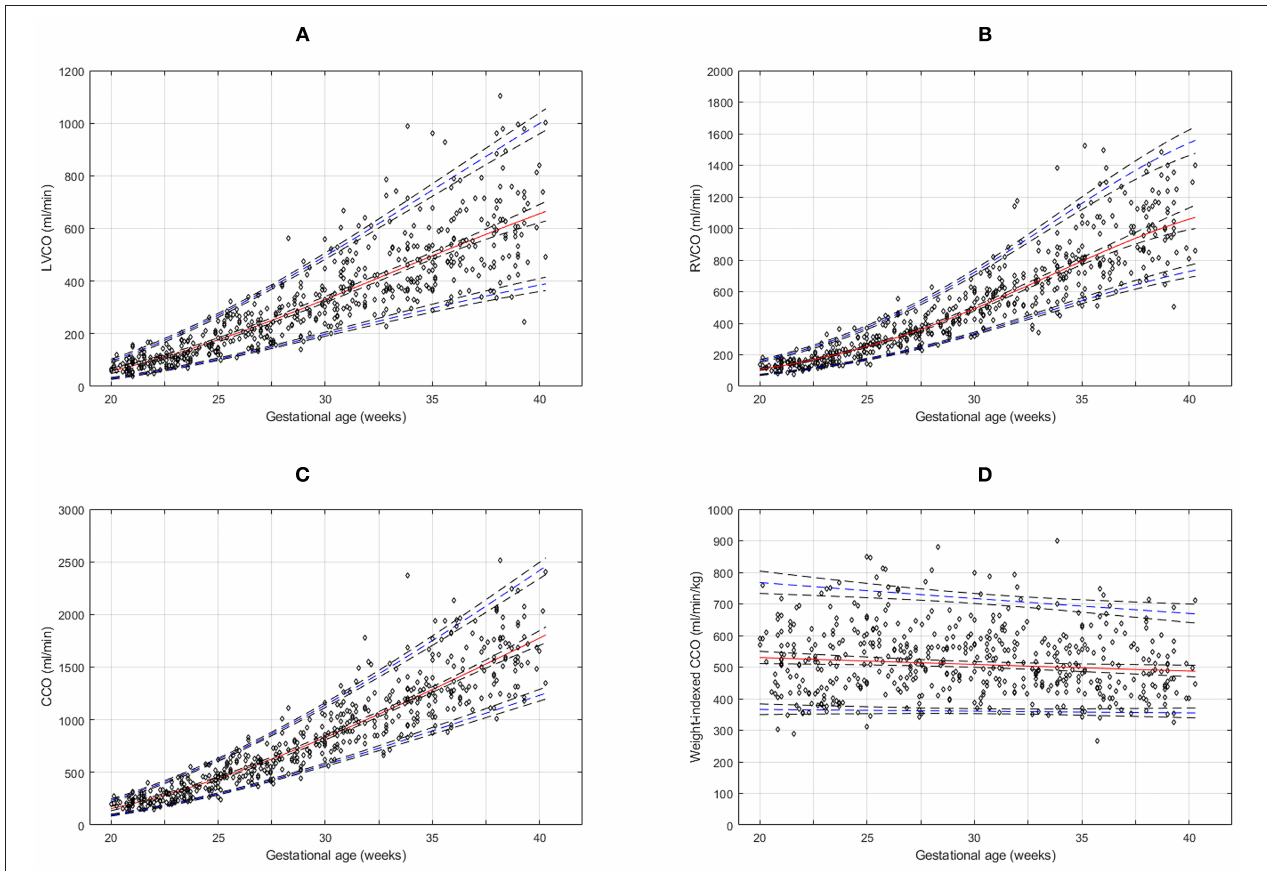
FIGURE 3 | Reference charts for fetal cardiac ventricular outputs: (A) left ventricular cardiac output (LVCO), (B) right ventricular cardiac output (RVCO), (C) combined ventricular cardiac output (CCO), and (D) normalized (weight-indexed) CCO at 20–40 weeks of gestation. The solid red line represents the 50th percentile, the blue lines represent the 5 and 95th percentiles and the interrupted black lines represent their respective 95% confidence limits.